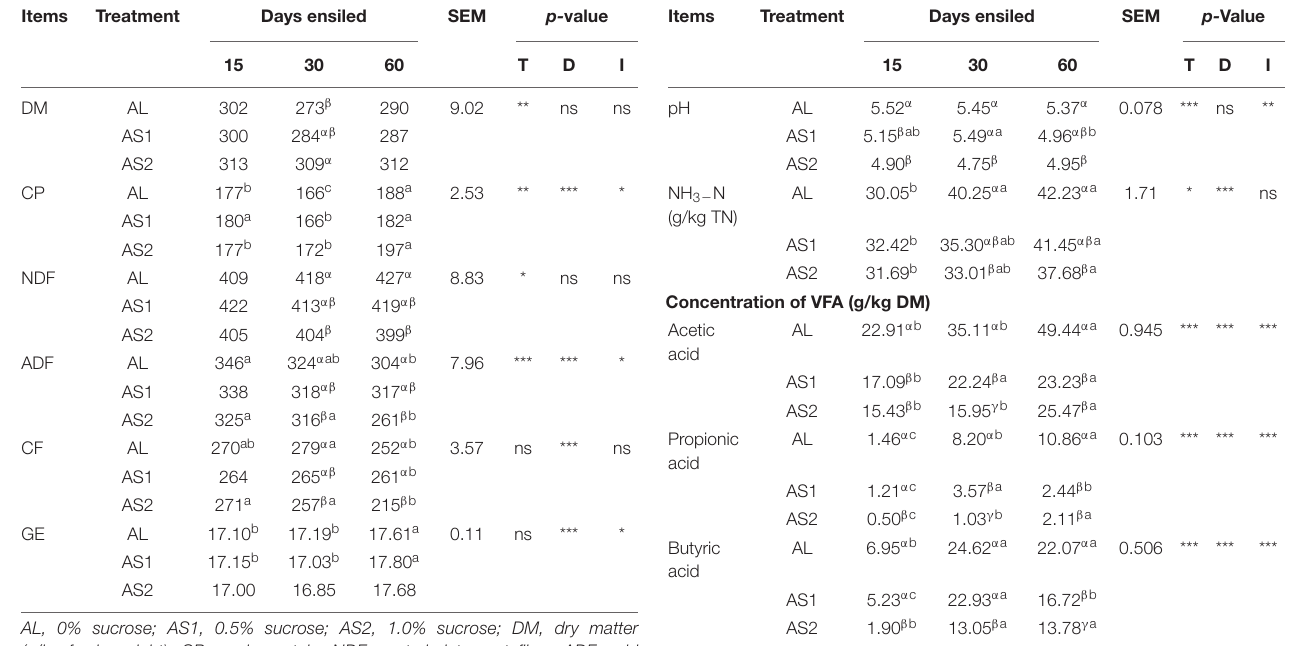
TABLE 3 | pH, NH 3 − N, and VFA of the different alfalfa silages. Items Treatment Days ensiled